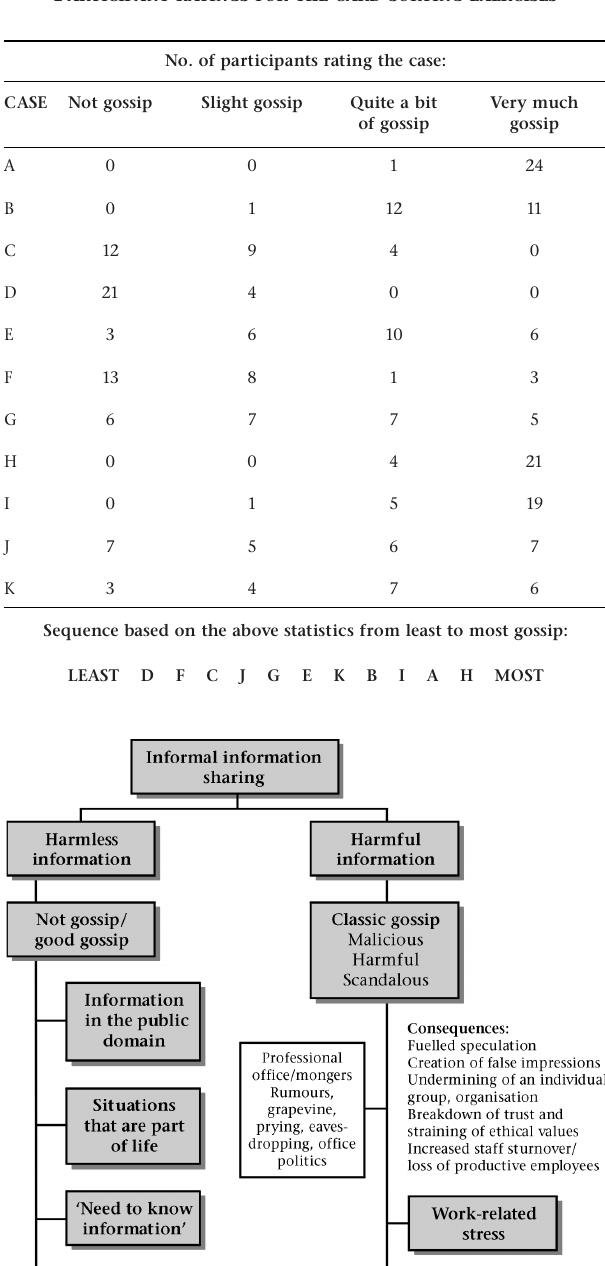
Figure 3. Information sharing can take place on two levels: sharing information that is harmless, and sharing information that is harmful. Information that is harmless